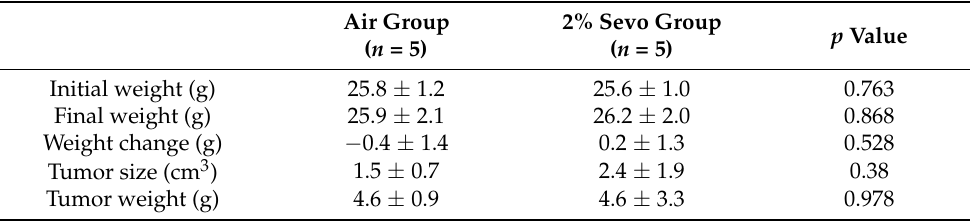
Table 1. Comparison of the measured values from the xenograft mouse model.